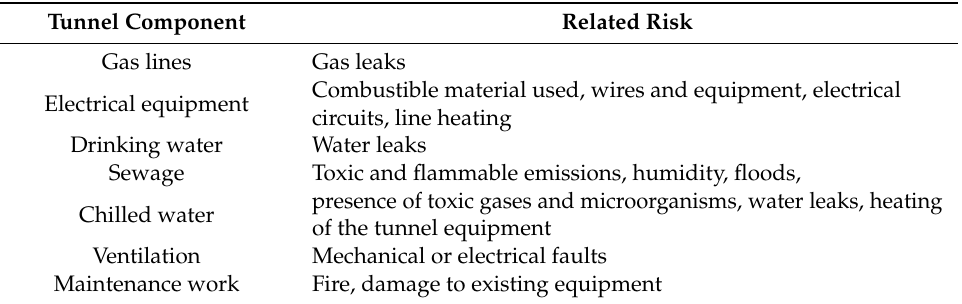
Table 1. Risk factors in the utility tunnel